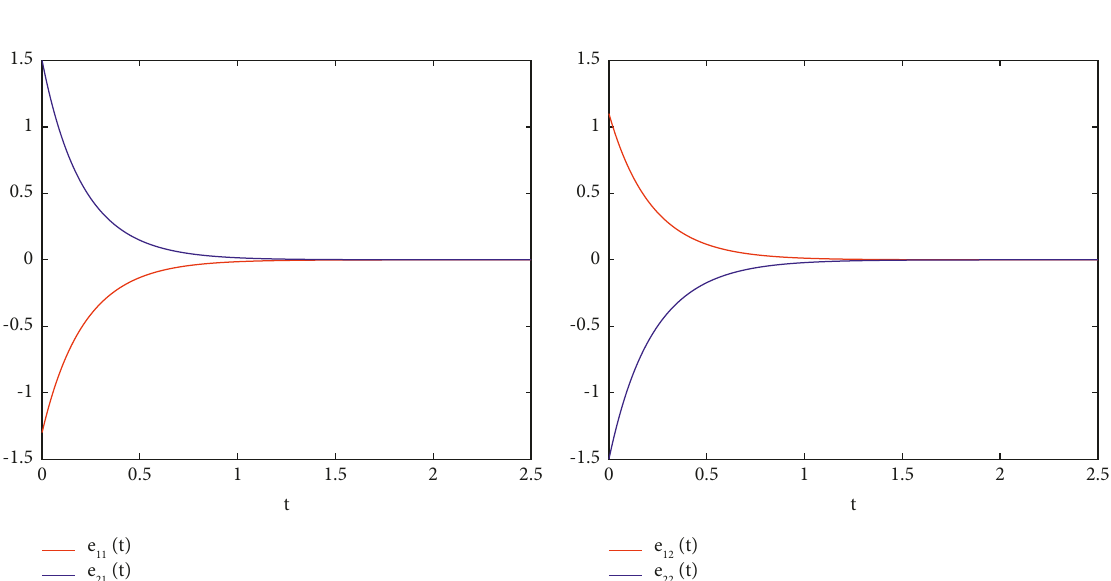
Figure 3: The convergent behavior of error system (80) under a linear control law.